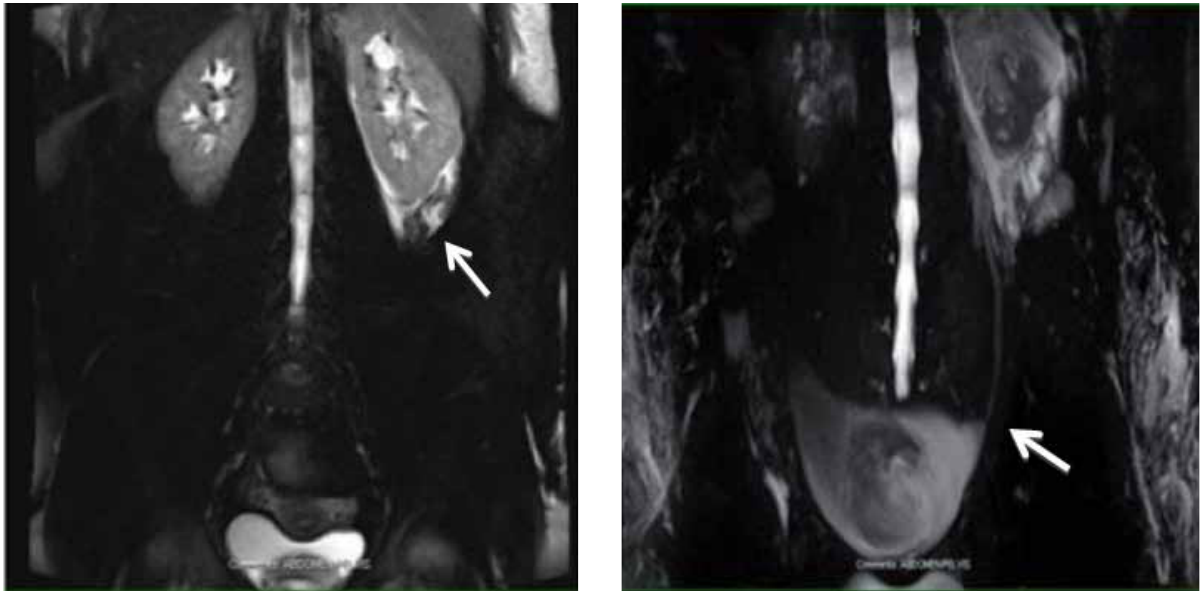
Figure 1 - Magnetic resonance urogram demonstrating A: Forniceal rupture with fluid within Gerota’s fascia (arrow). B: Forniceal rupture and fluid within Gerota’s fascia again demonstrated as well as a 3 mm distal ureteral calculus